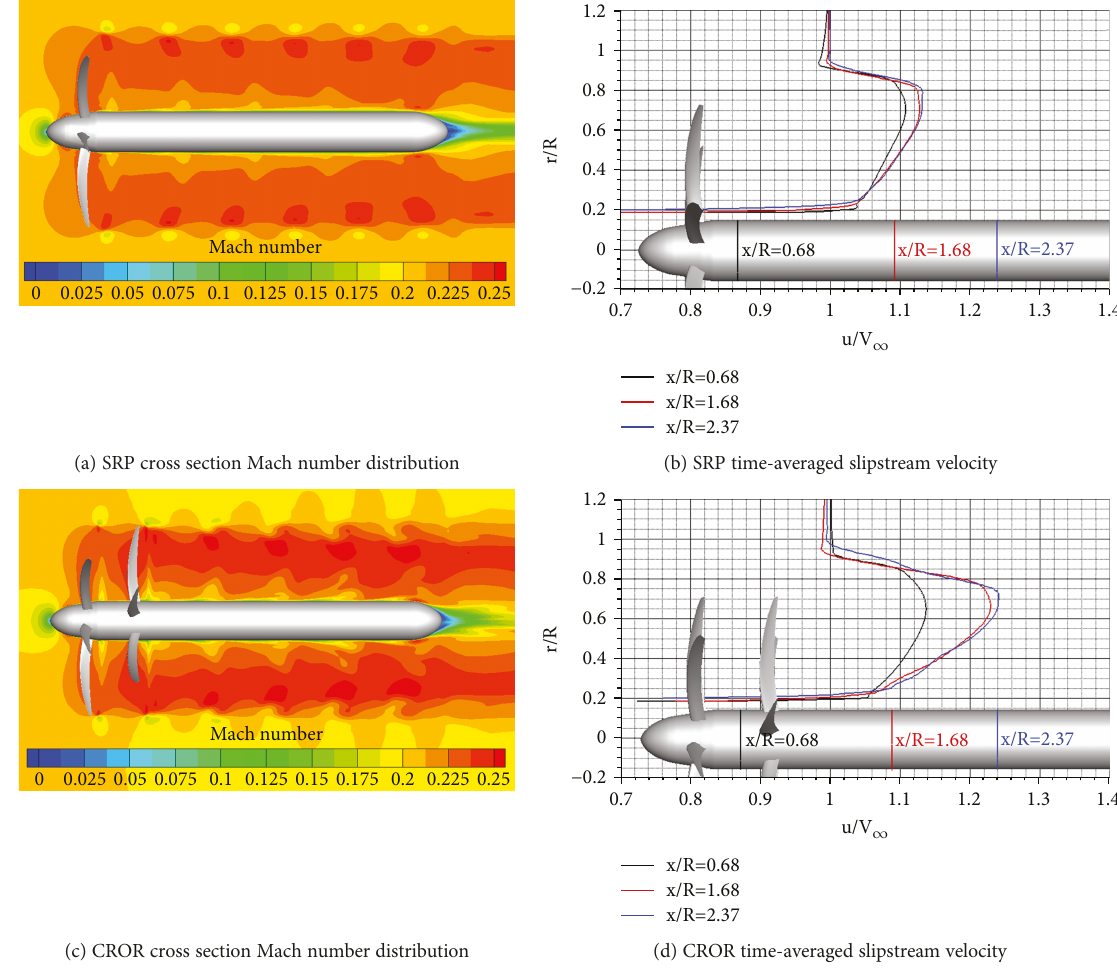
Figure 14: Slipstream acceleration e ff ect; J = 1 73779